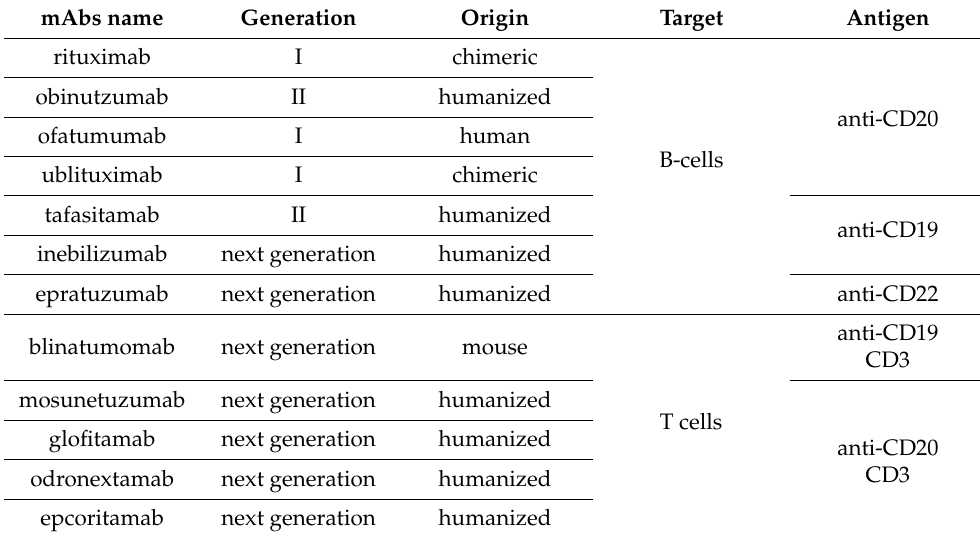
Table 3. mAbs used in NHL therapy in children